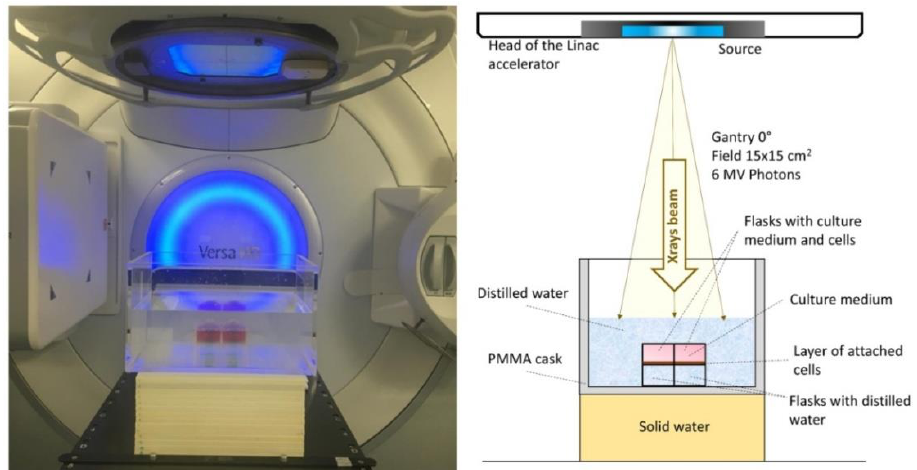
Figure 3. Experimental arrangements for cell irradiations with photons used at the medical linear accelerator in Granada. Two flasks with a layer of cells are irradiated at the same time with the same dose.